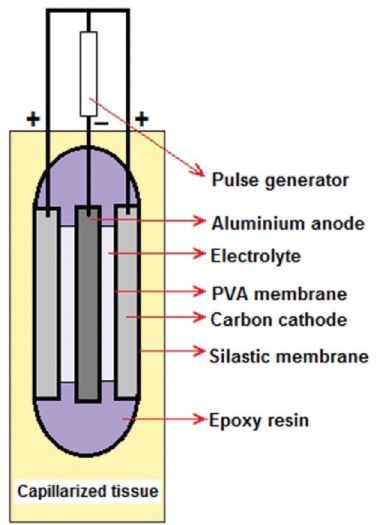
Fig. 5. The construction of an implanted abiotic glucose fuel cell [37].